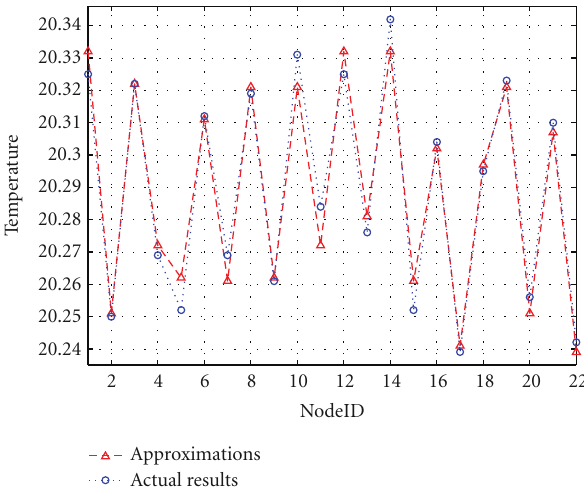
Figure 9: Approximation obtained for the sensor